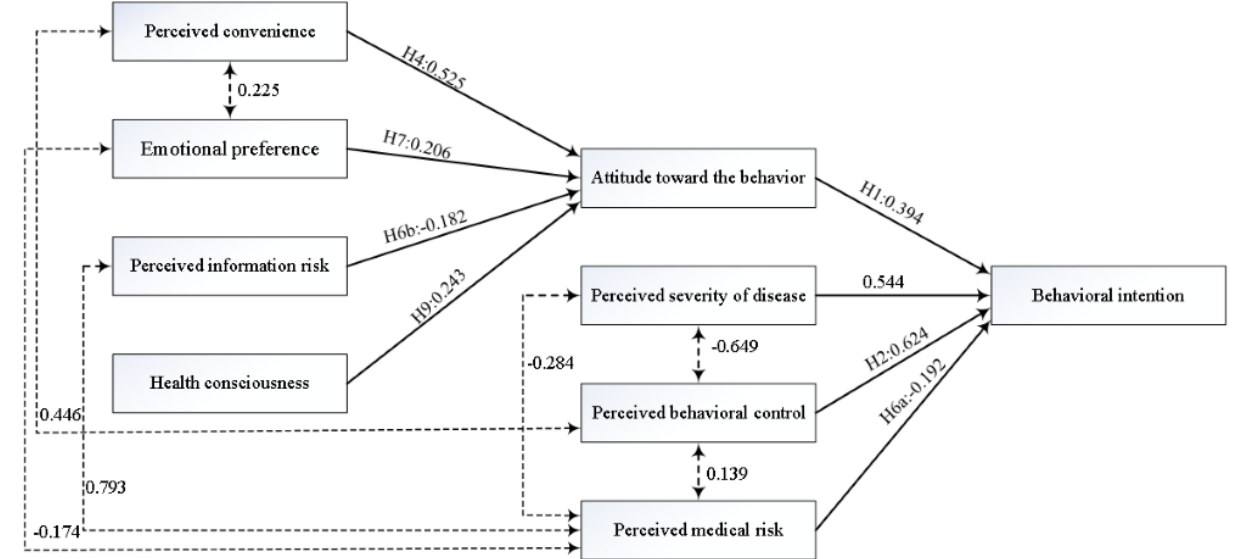
Figure 2. Results of the final research